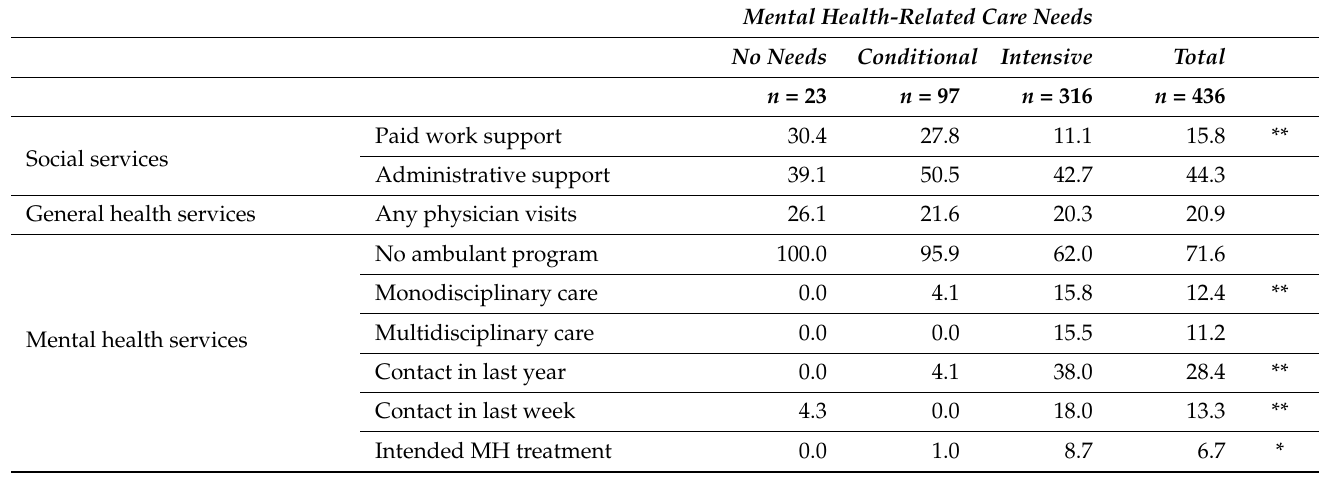
Table 3. Service presence and